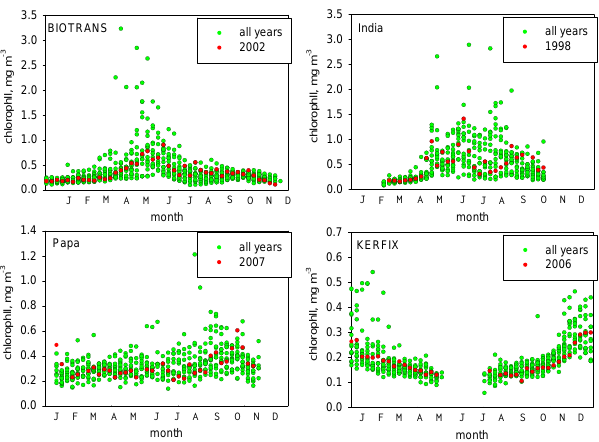
Figure 9. SeaWiFS chlorophyll data (mgm − 3 ) for each of the four stations, years 1998–2013 overlaid, with selected median year (see text)